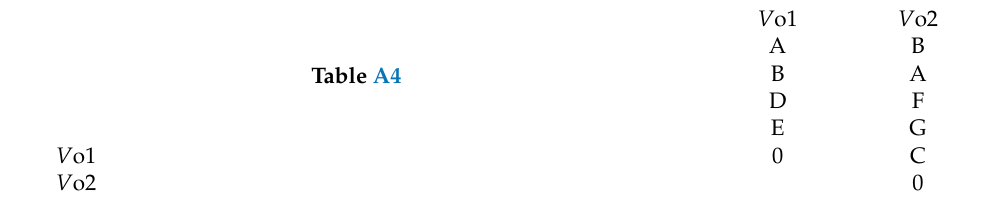
Table A9. Configurational Matrix (mutual interatomic distances in NN, as in Table A2) for x = 0.25,